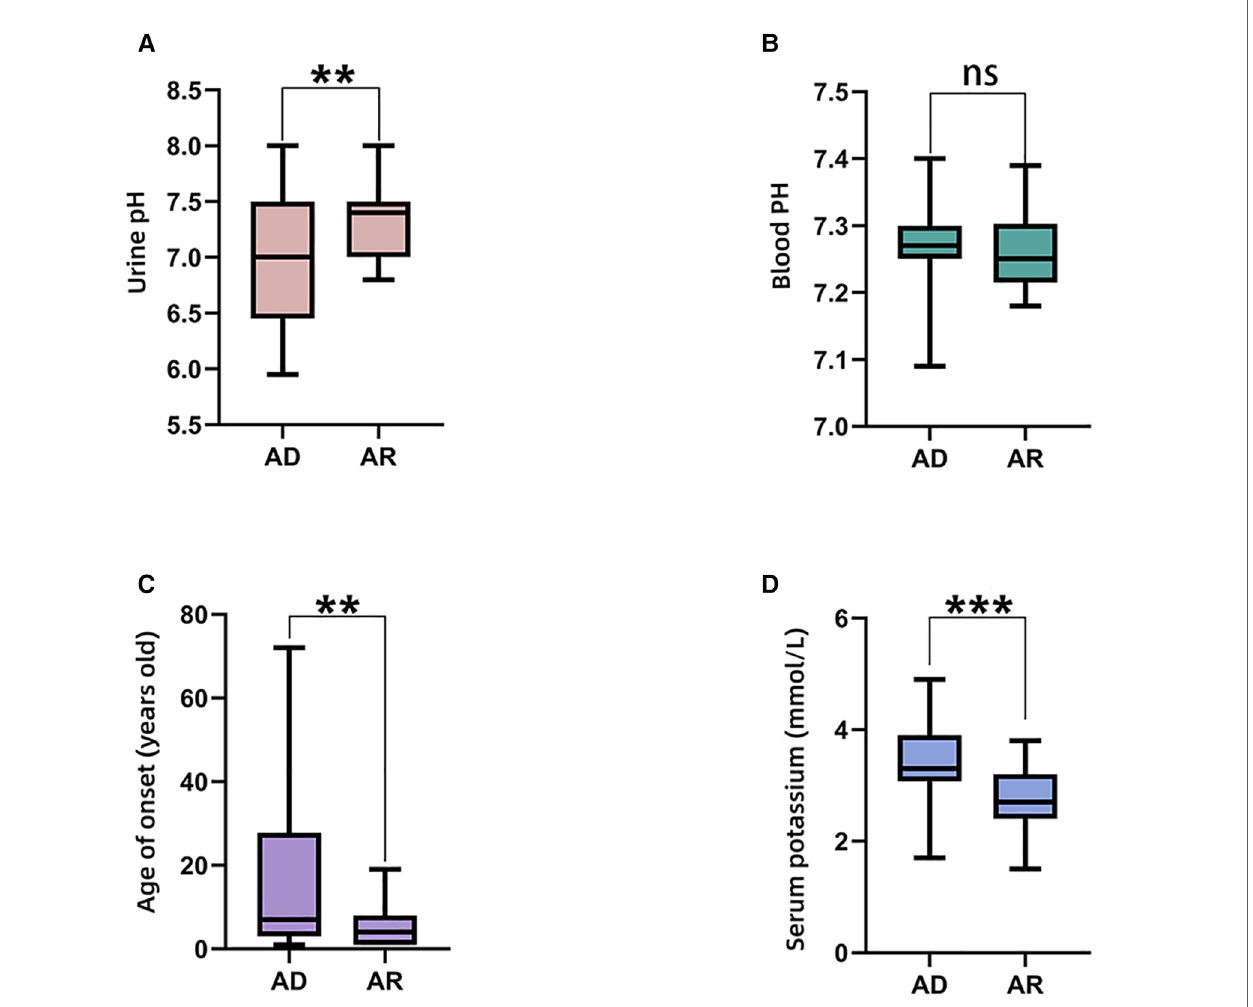
FIGURE 4 The comparisons of biochemical indexes and age of onset between AD and AR. ( A ). Urine pH; ( B ). Blood PH; ( C ). Age of onset; ( D ). Serum potassium. * P <0.05; ** P <0.01; *** P <0.001; ns: P